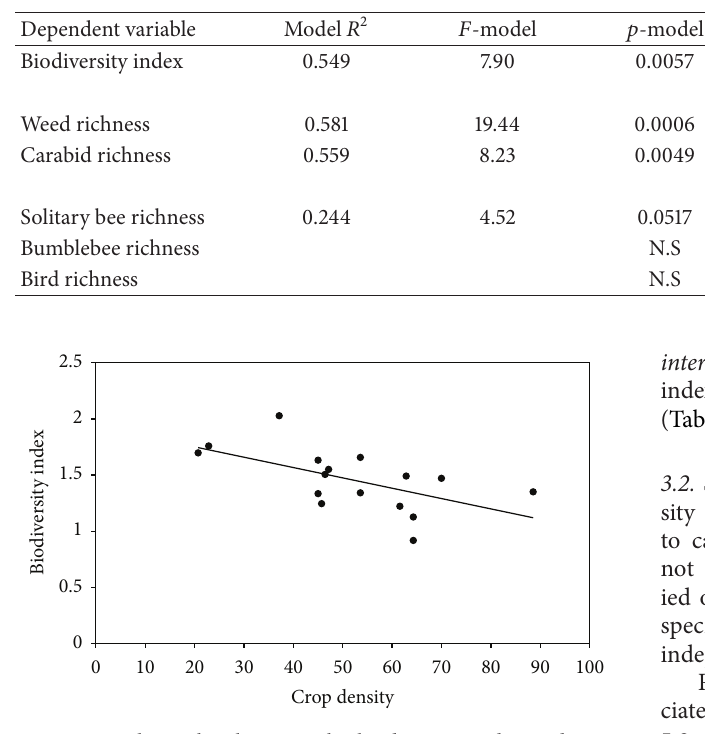
Figure 1: Relationship between the biodiversity index and crop density(percentcover).Therelationshipwassignificant( 𝑅 2 = 0.341 , 𝑃 = 0.0176